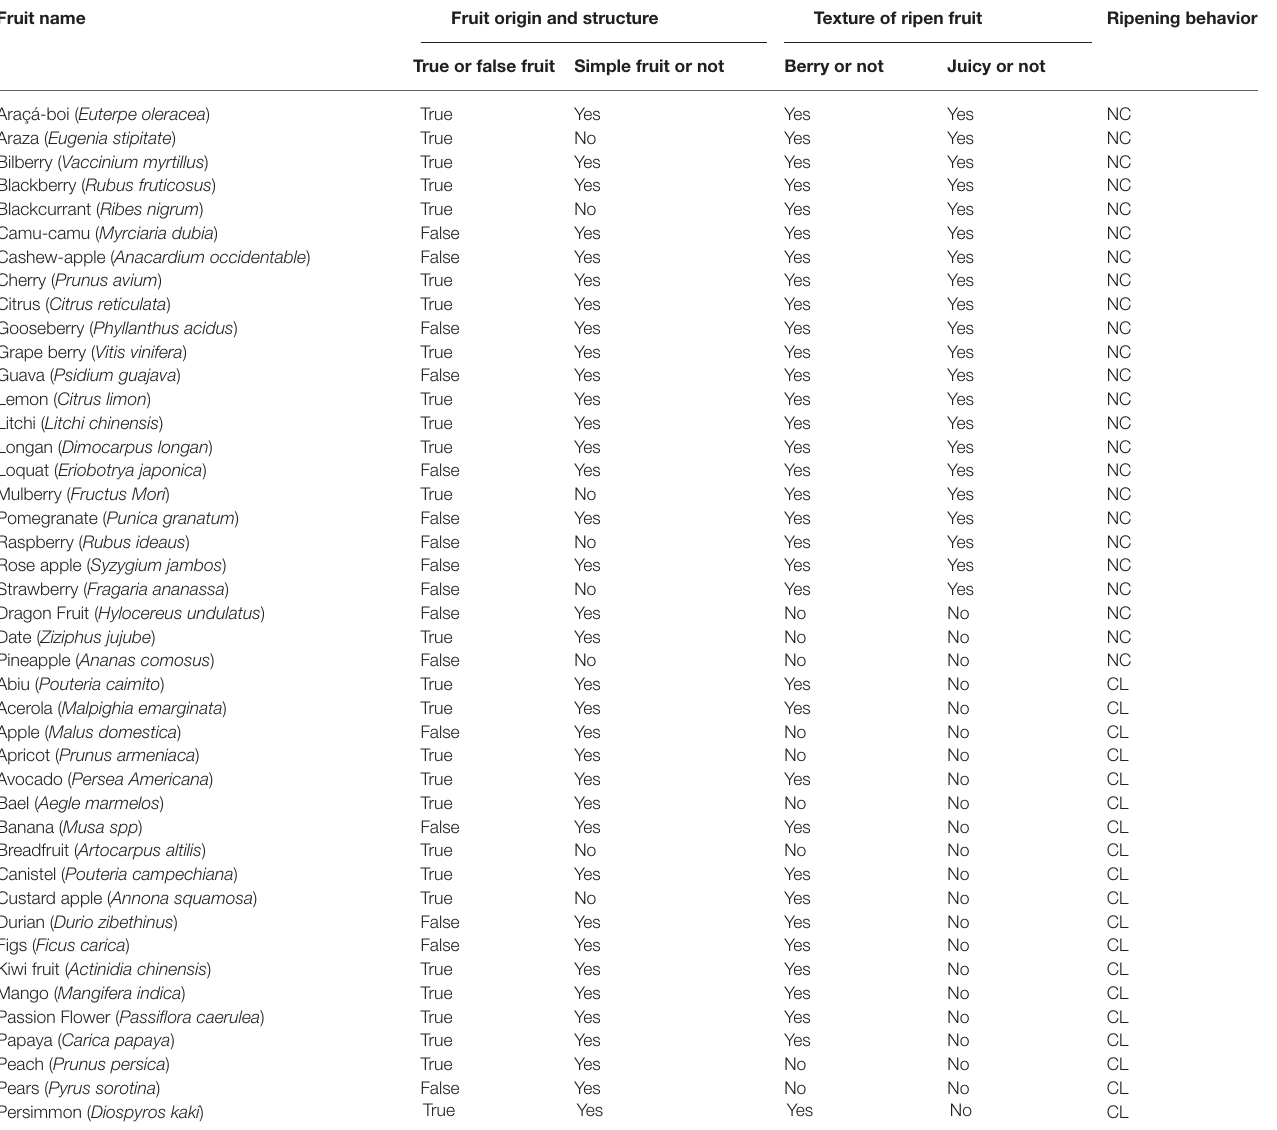
TABLE 1 | Comparison of fruit origin, structure, and ripening behaviors between CL and NC fruits. Fruit name Fruit origin and structure Texture of ripen fruit Ripening